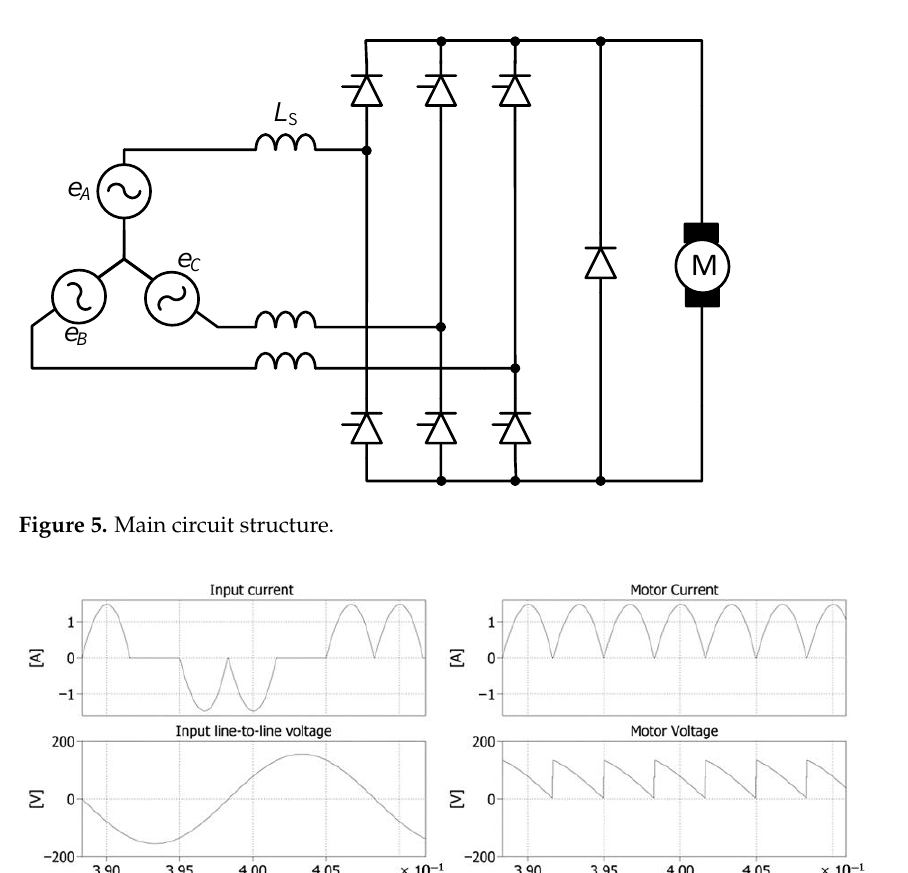
Figure 6. Simulation results for the firing angle of the rectifier’s thyristors equal to 60°.